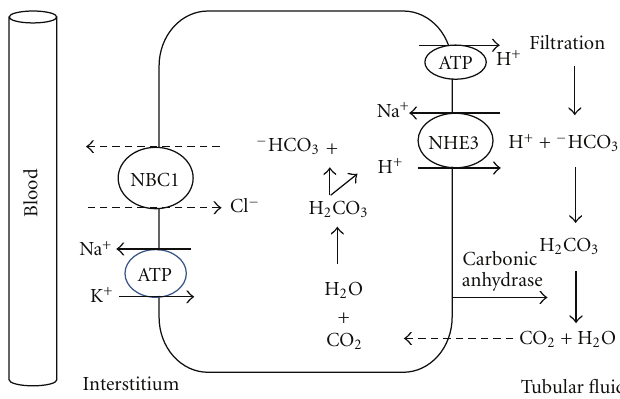
Figure 1: H + secretion and − HCO 3 reabsorption in the tubular cells.